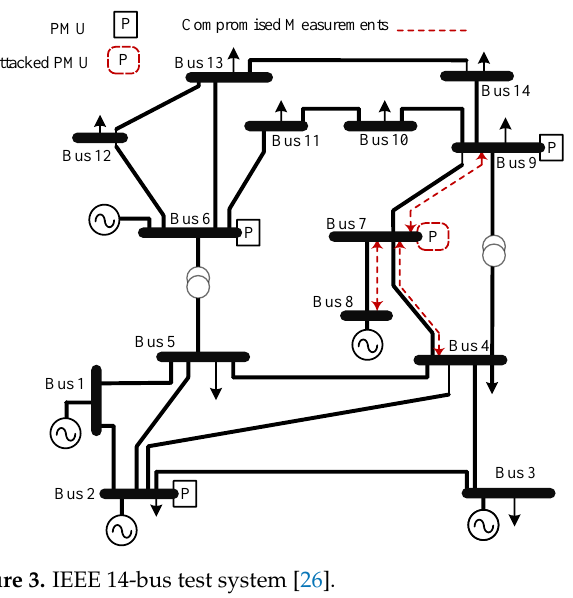
Figure 3. IEEE 14-bus test system [26].